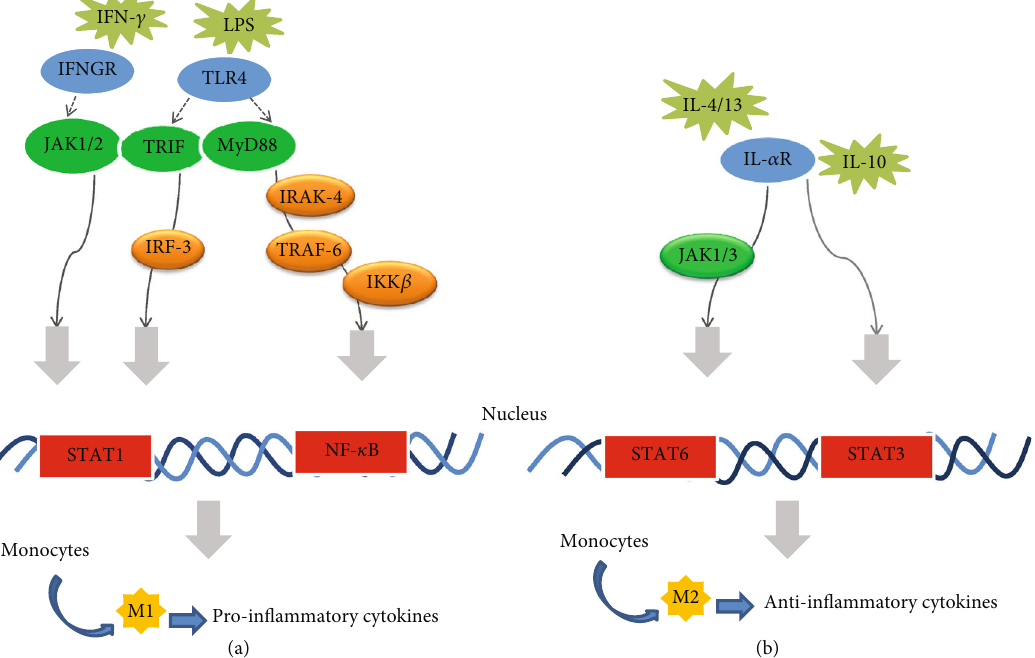
Figure 1: Several signaling pathways mediate in macrophage polarization. (a) M1 macrophage polarization and (b) M2 macrophage polarization are shown with some signal pathways or factors involved in their development. Although this graph displays two categories of macrophage, in fact a dynamic spectrum of polarization often occurs. Abbreviations: IFN- γ : interferon gamma; LPS: lipopolysaccharide; IFNGR: interferon gamma receptor; TLR4: Toll-like receptor-4; JAK1/2/3: Janus kinase1/2/3; TRIF: TLR domain-containing adapter protein inducing interferon- β ; MyD88: myeloid di ff erentiation factor 88; IL-4/10/13: interleukin 4/10/13; IL- α R: interleukin receptor;